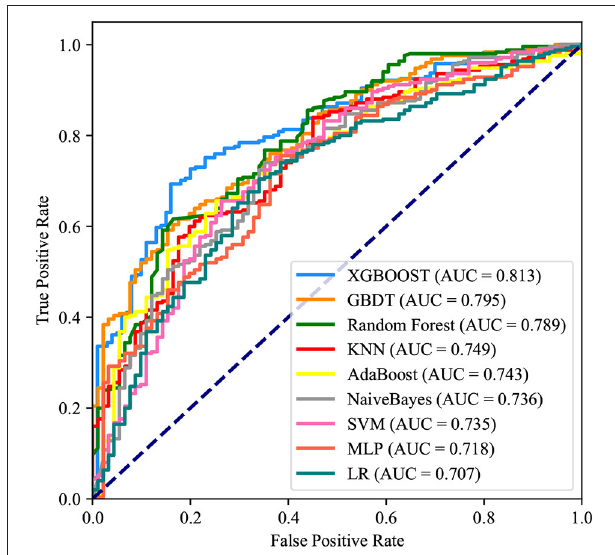
FIGURE 2 | Receiver operating characteristic curves for the machine learning model and logistic regression. XGBOOST, eXtremely Gradient Boosting; GBDT, Gradient Boosting Decision Tree; KNN, K-Nearest Neighbor; SVM, Support Vector Machine; MLP, Multi-Layer Perceptron; LR, Logistic Regression.